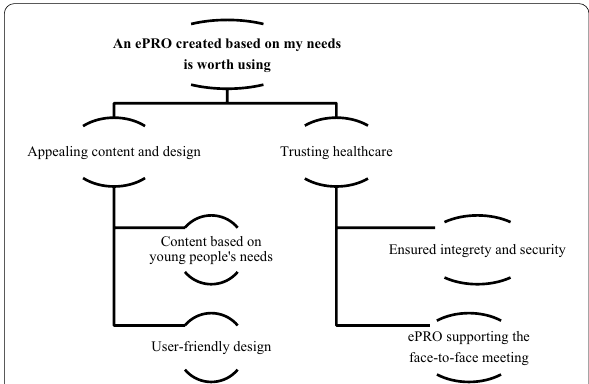
Fig. 1 Overview of the result, presenting the theme at the top and the two sub-themes with two categories each